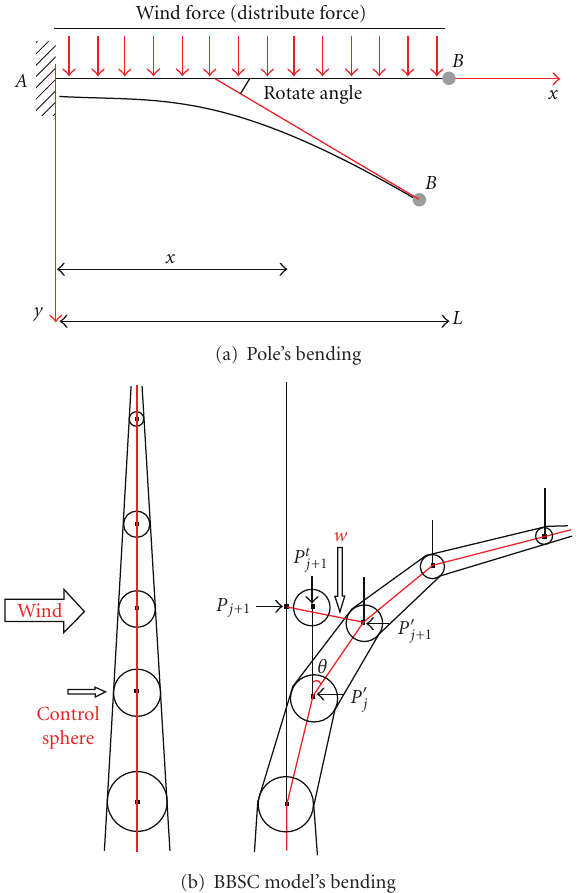
Figure 6: BBSC model’s bending by simulating pole’s bending.